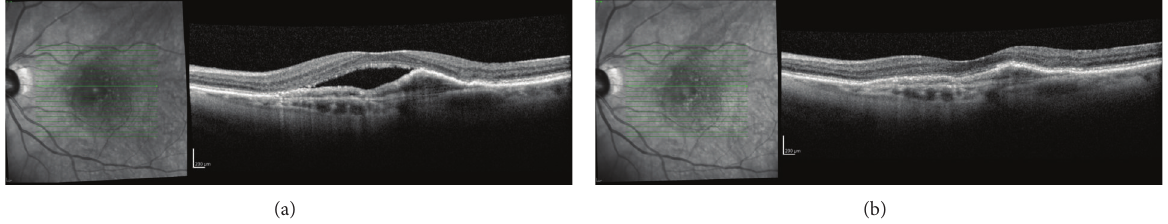
Figure 2: A patient with AMD previously treated with 4 intravitreal ranibizumab injections shows persistent subretinal retinal fluid on OCT (a). Following one intravitreal aflibercept injection (b) there was marked reduction of subretinal fluid and reduced CRT, 7.61 to 6.88 mm 3 and 442 to 223 𝜇 m,